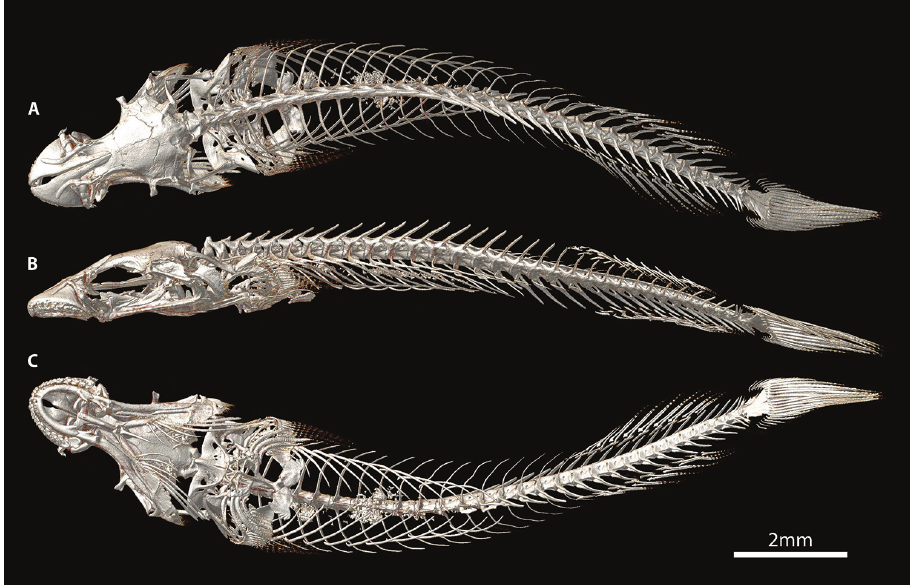
Figure 4. CT scanned skeleton of Flexor incus , AIM MA655316, paratype, 23.0 mm SL. A Dorsal view. B Lateral view (left side) C Ventral